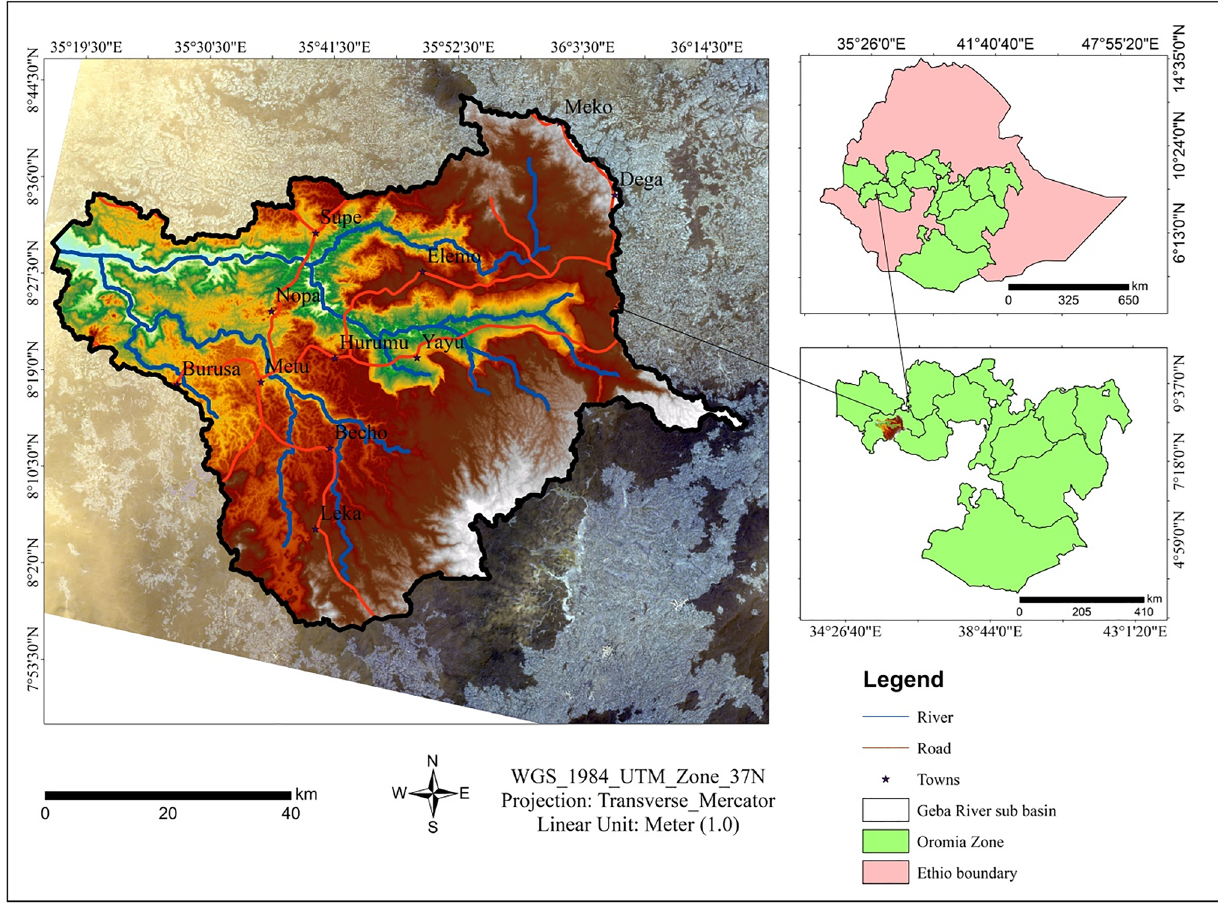
Fig. 1 Location of the study area: Geba watershed-Geba River Sub-basin